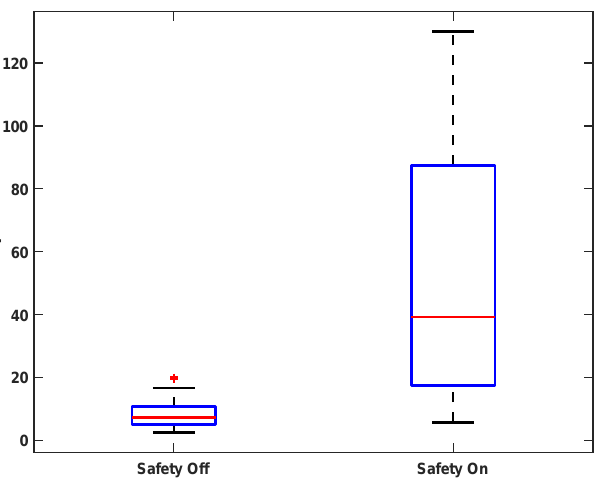
Figure 10. Times to acquire porcine vessel with safety logic off and on. Box-and-whiskers format displays median, interquartile range (IQR, box), ± 1.5 IQR (whiskers), and individual data points outside of whiskers.